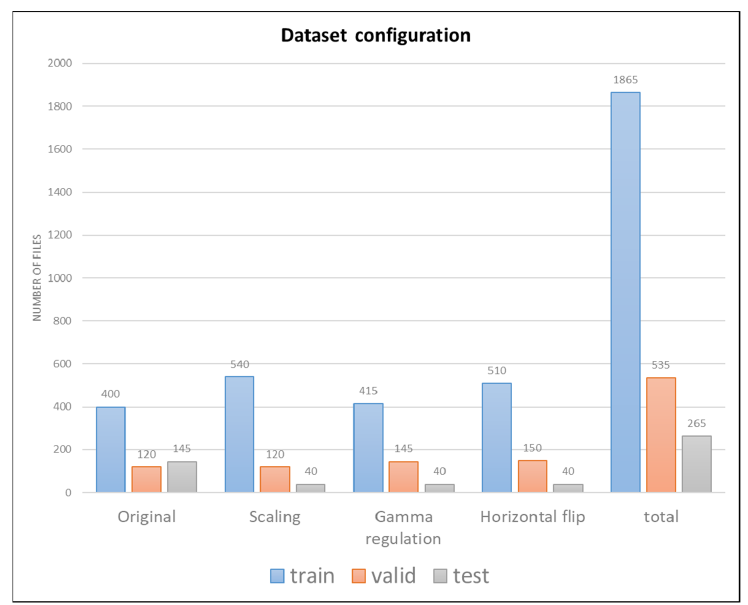
Figure 3. Pothole dataset configuration after data augmentation.